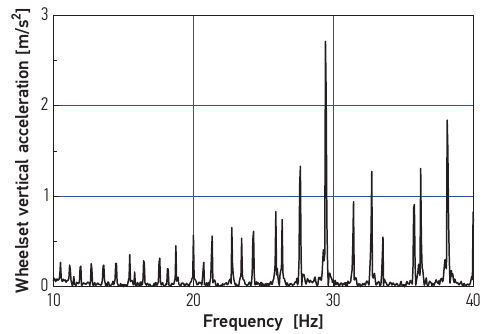
Fig. 14. The frequency of the wheelset vertical vibration